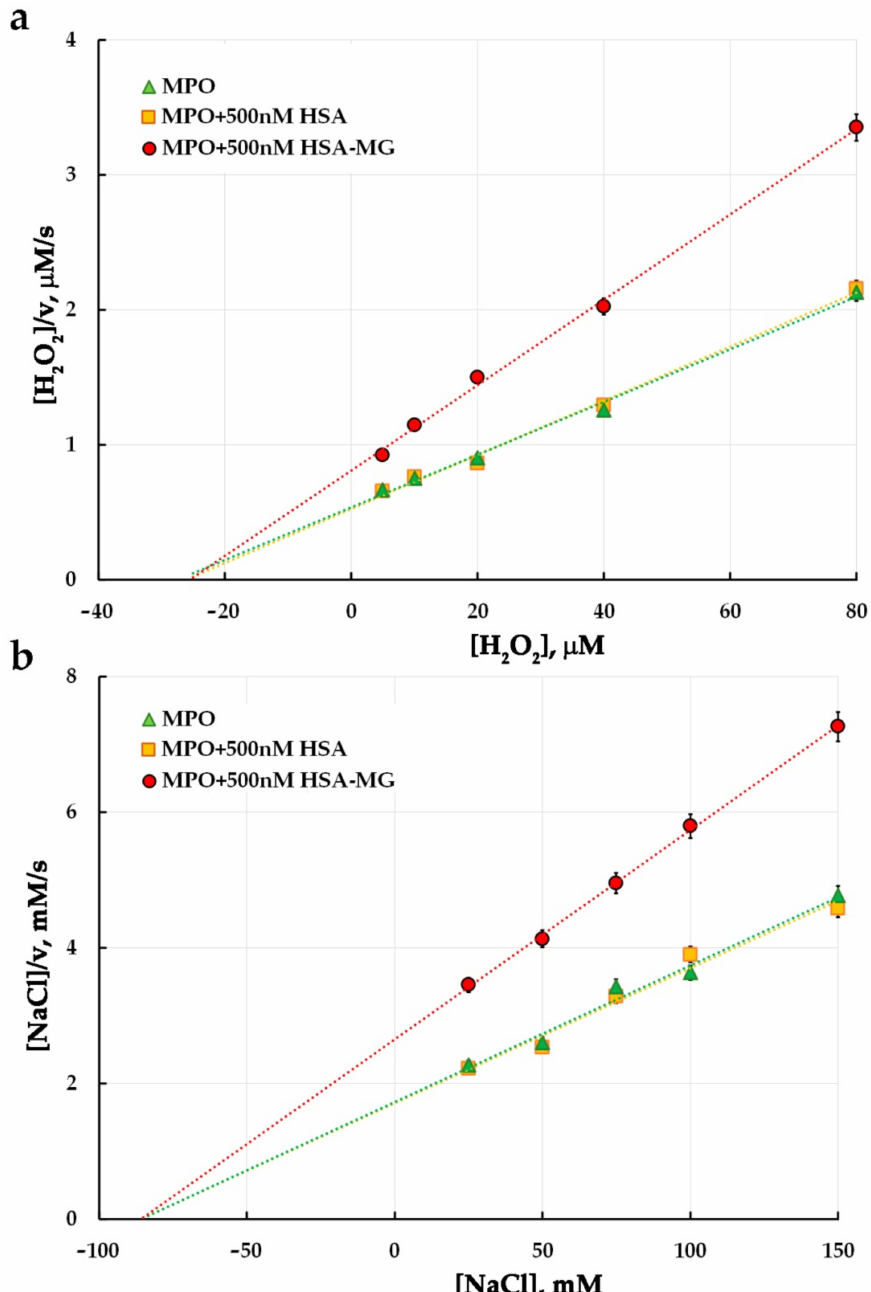
Figure 6. Hanes–Woolf plots illustrating the effect of HSA-MG on kinetics of MPO-catalyzed chloride oxidation ( n = 3). ( a ) The mixture contained 150 mM NaCl, 10 nM MPO, 200 µ M CB, 2 mM Tau, 10 µ M KI, 5–80 µ M H 2 O 2 in 20 mM sodium–phosphate buffer, pH 5.8; HSA or HSA-MG were added to achieve concentration of 0.5 µ M. ( b ) The mixture contained 50 µ M H 2 O 2 , 10 nM MPO, 200 µ M CB, 2 mM Tau, 10 µ M KI, 25–150 mM NaCl in 20 mM sodium–phosphate buffer, pH 5.8; HSA or HSA-MG were added to achieve concentration of 0.5 µ